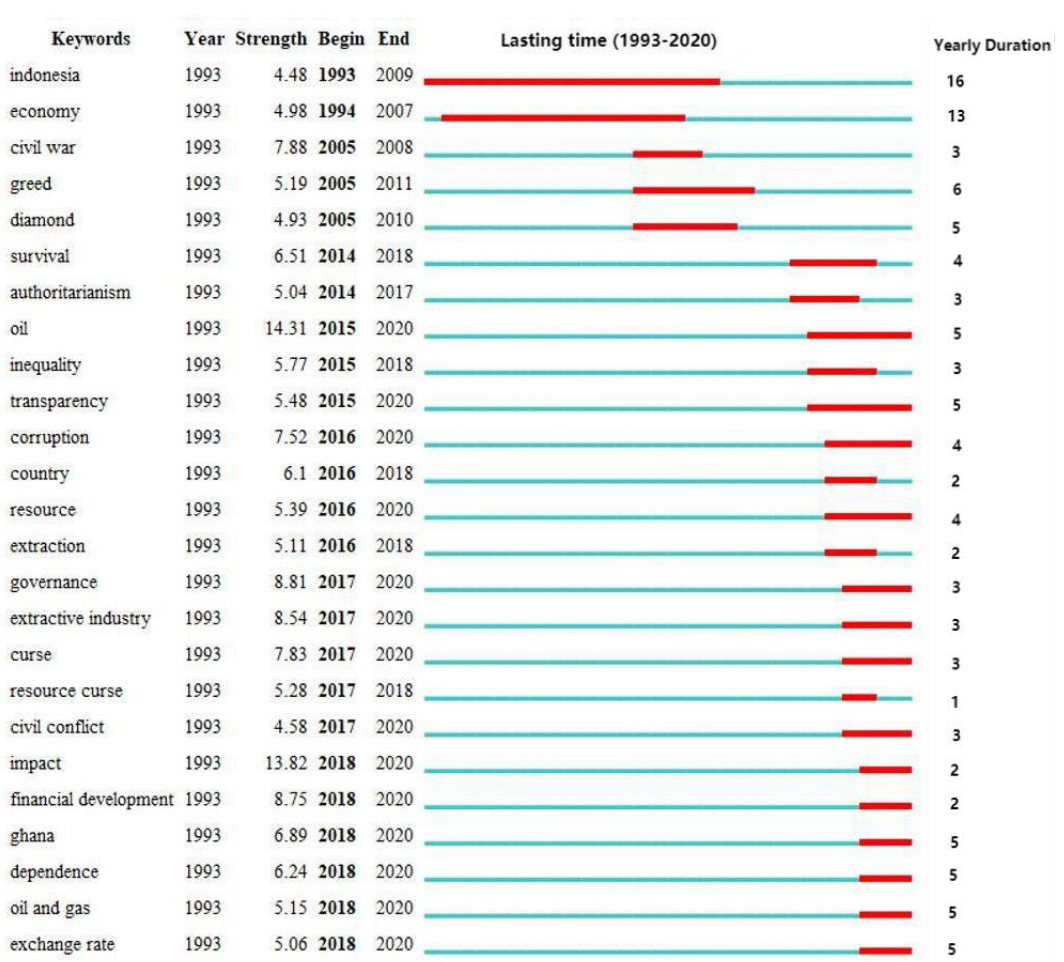
Figure 18. Top 25 keywords with the most robust occurrence